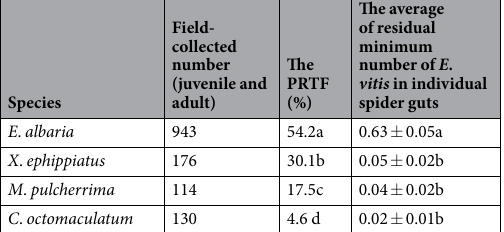
Table 4. The PRTF (positive rates of target fragment) and residual minimum number of E . vitis in per dominant spider species. Values presented as mean ± SE. Residual minimum number of E . vitis in individual spider guts = N / M ( N is the CNTF (copy numbers of target fragment) of field-collected individual spiders; M is the CNTF of individual spiders which feeding one adult E . vitis after 0 hour digestion). The different lowercase in same column indicate significant difference in P < 0.05 level.